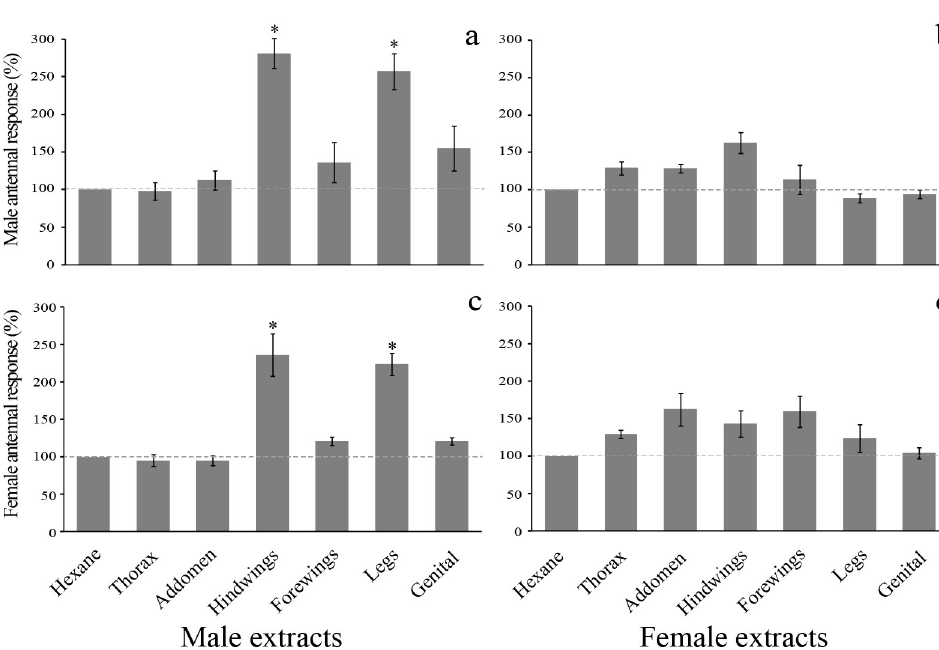
Fig 6. EAG responses to body extracts of Telchin licus . Mean ( ± SEM) EAG responses [expressed as the mean percentage values with respect to the control (hexane = 100%)] for the antennae of male T . licus to (a) male body extracts and (b) female body extracts and for the antennae of female T . licus to (c) male body extracts and (d) female body extracts. Bars with ( � ) are significantly different relative to hexane (p < 0.05; Mann-Whitney test; N = 7 antennae of each